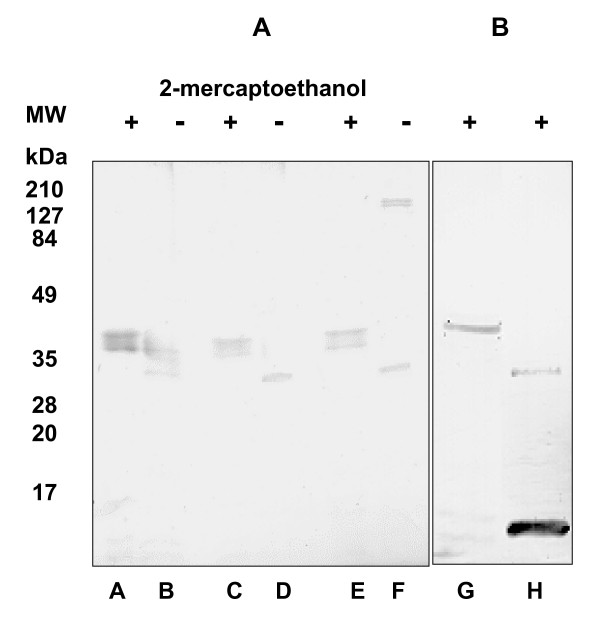
Electrophoretic mobility of recombinant chimeric protein in reduced and non-reduced conditions. Panel A: The antagonist was identified in a Western blot using a rabbit anti-IL-2 polyclonal antibody. The analyzed TH1 antagonist preparations were those obtained from the 8 M urea extraction, (lanes a and b), gel filtration fraction in 4 M urea (lanes c and d) and after dialysis against PBS (lanes e and f). Panel B: Western blot to identify the TH1 antagonist after dialysis against PBS (lane g) and IL-2 (lane h) in reduced conditions using the anti-IL-2 antibody.